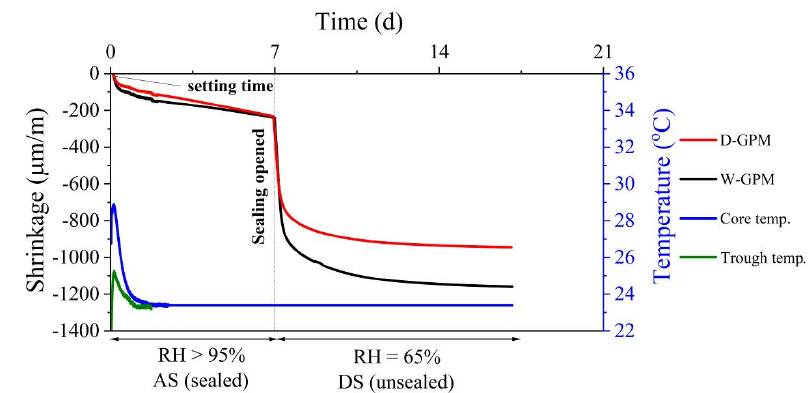
Figure 5. Compressive and tensile strength development of GPM versus normal concrete PCC according to model code 2010 (with standard deviation).